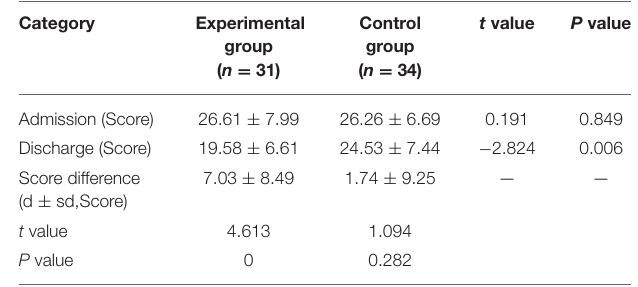
TABLE 1 | Comparison of general conditions of two groups of patients.